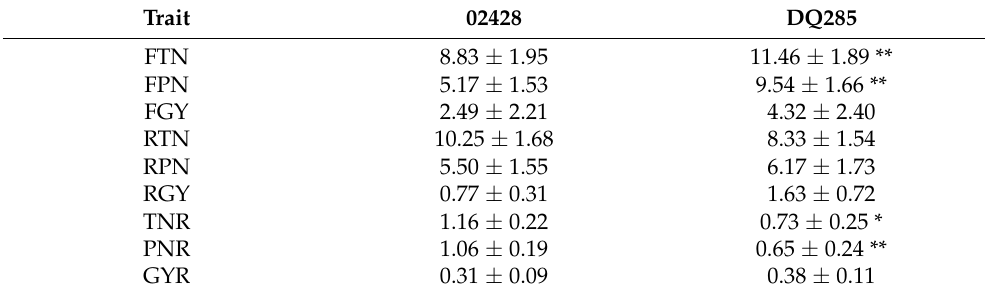
Table 5. Comparison of ratooning-ability-related traits between DQ285 at 02428 background and 02428. Trait